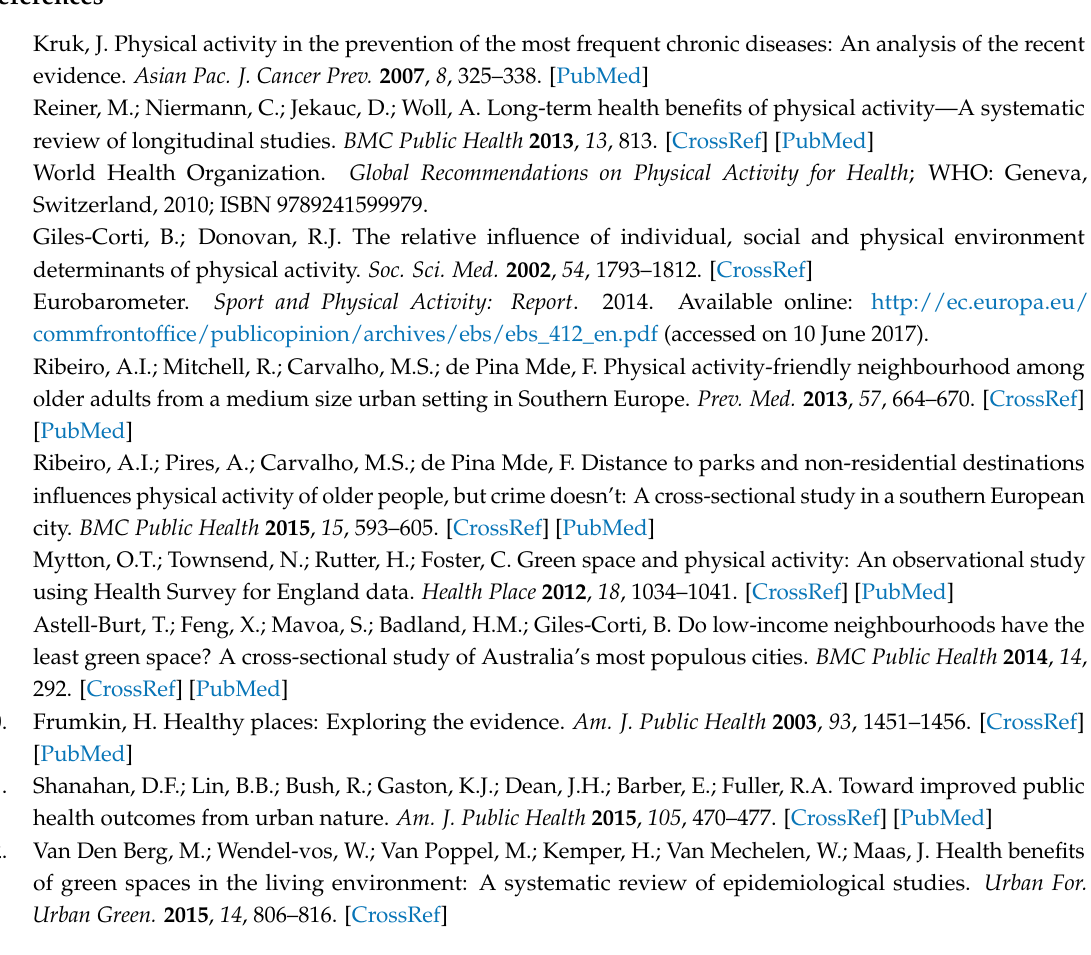
Table S1: Included and excluded items and recodification criteria. Table S2: Sensitivity analysis. Table S3: Correlation matrix: (A) Quality scores; (B) Geographic